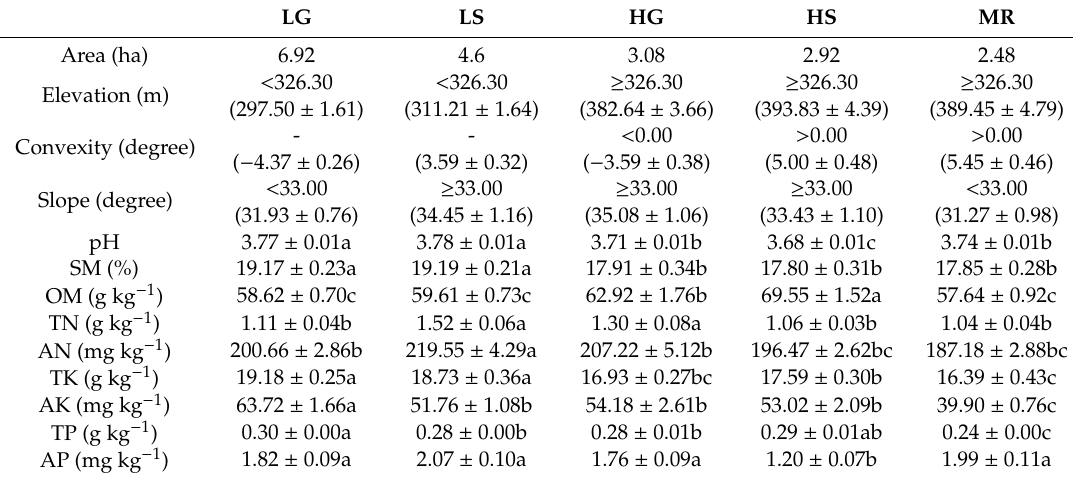
Table 1. Criterions and soil properties of five habitat types at 20 m × 20 m spatial scale for 20-ha DHS plot,